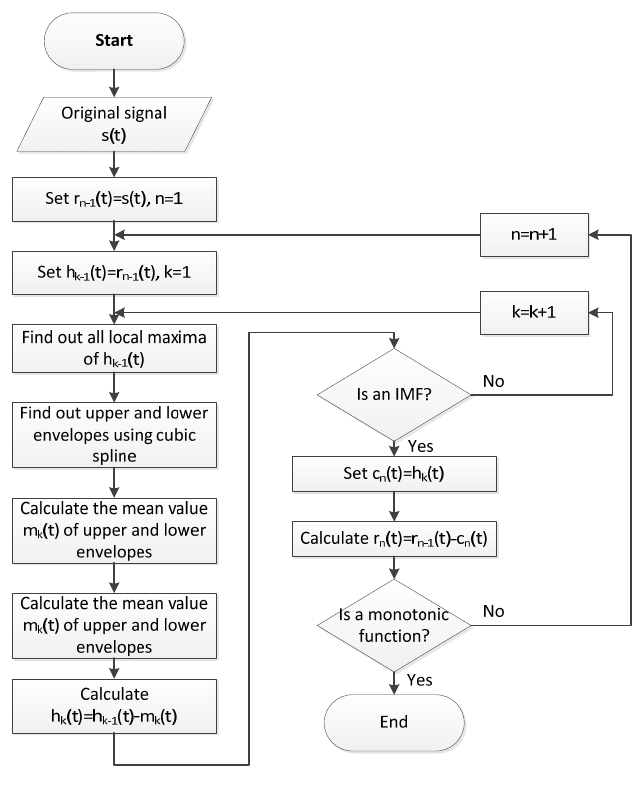
Figure 8. The flowchart of the EMD algorithm.